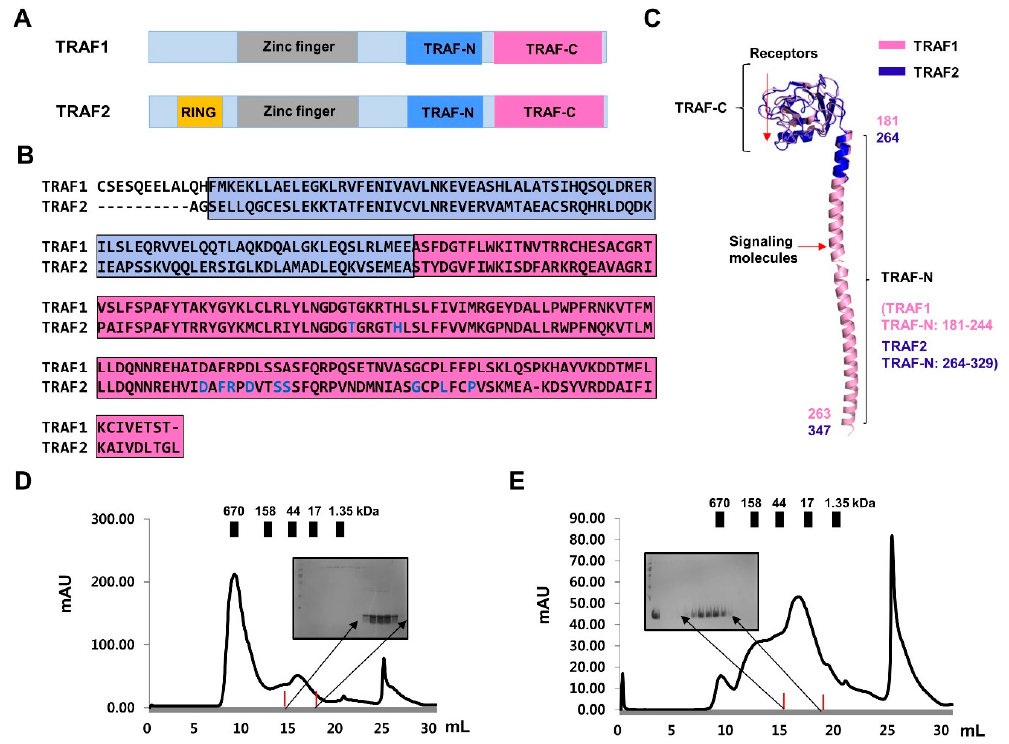
Figure 2. Purification of TRAF-N CC domains of TRAF1 and TRAF2. ( A ) The domain boundary of TRAF1 and TRAF2; ( B ) Sequence alignment of TRAF domains of TRAF1 and TRAF2. Blue and pink boxes indicate the TRAF-N CC and TRAF-C domains, respectively. Blue letters indicate the residues involved in the interaction with various receptors; ( C ) Ribbon diagram of the monomeric structure of TRAF1 (Pink) and TRAF2 (Blue) TRAF domain. The number of amino acids of TRAF1 TRAF-N (Pink) and TRAF2 TRAF-N (Blue) constructs used in this study are shown. D and E. Size-exclusion chromatography profiles of TRAF1 TRAF-N CC ( D ) and TRAF2 TRAF-N CC ( E ). Eluted target proteins are shown by SDS-PAGE.